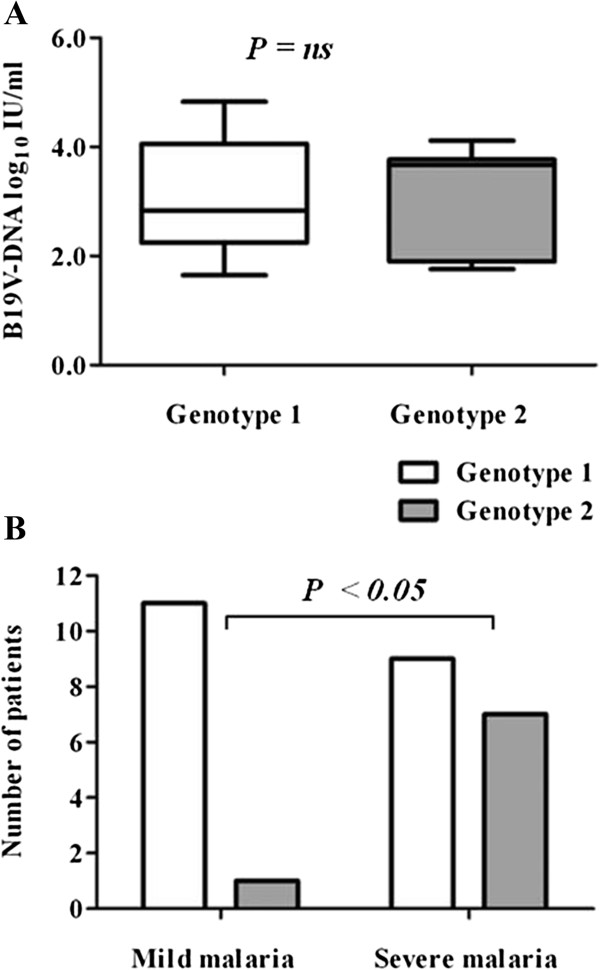
B19V genotype-specific distribution and viral loads in B19V/P. falciparum coinfected malaria patients. (A) B19V genotype-specific viral loads was not significantly different between the malaria patient groups (median, 2.83 log10 IU/ml (range 1.65-4.83 IU/ml) vs 3.67 log10 IU/ml (range 1.76-4.11 IU/ml), P=ns (Mann–Whitney U test). (B) Prevalence of B19V genotypes 1 and 2 in mild and severe malaria patient groups. The prevalence of B19V-genotype 2 was significantly higher in severe malaria than in mild malaria (OR = 8.56 (CI95 [0.88-83.1], one-tailed Fisher’s exact test, P<0.05).